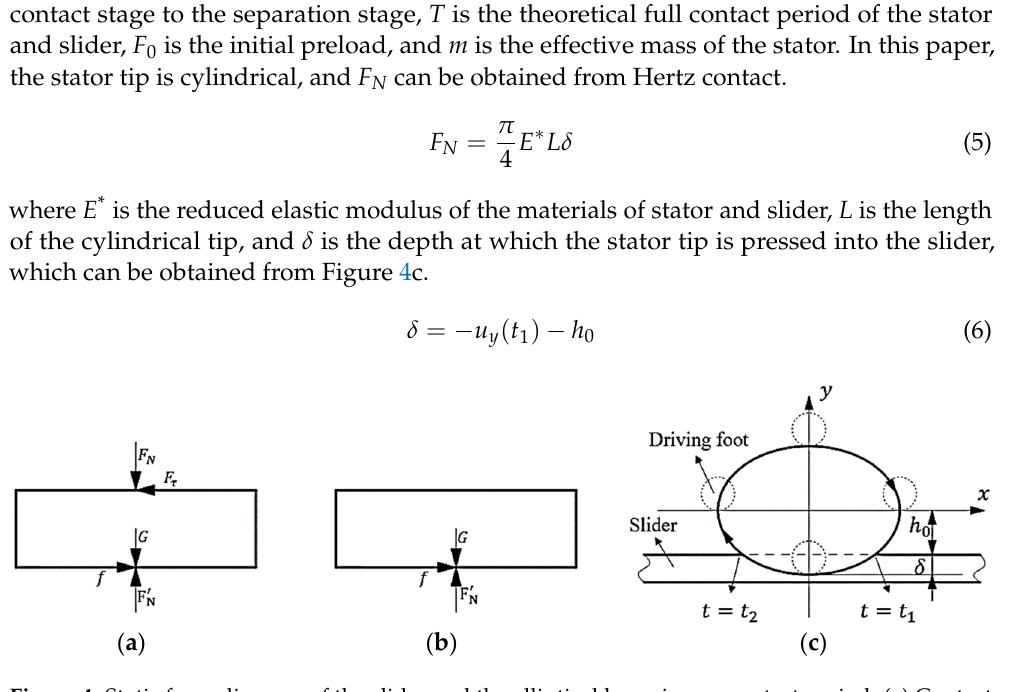
Figure 4. Static force diagram of the slider and the elliptical locus in one contact period. ( a ) Contact stage, ( b ) separation stage, and ( c ) elliptical locus in a contact period.